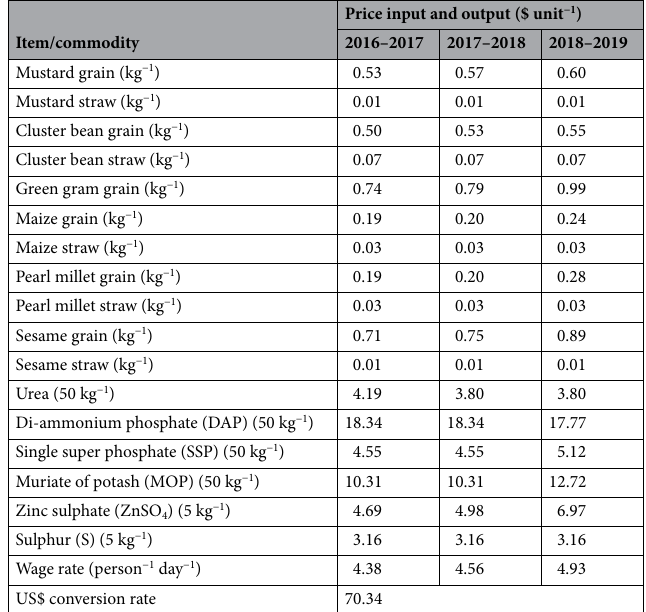
Table 9. Cost of key inputs and outputs used for economic analysis during different